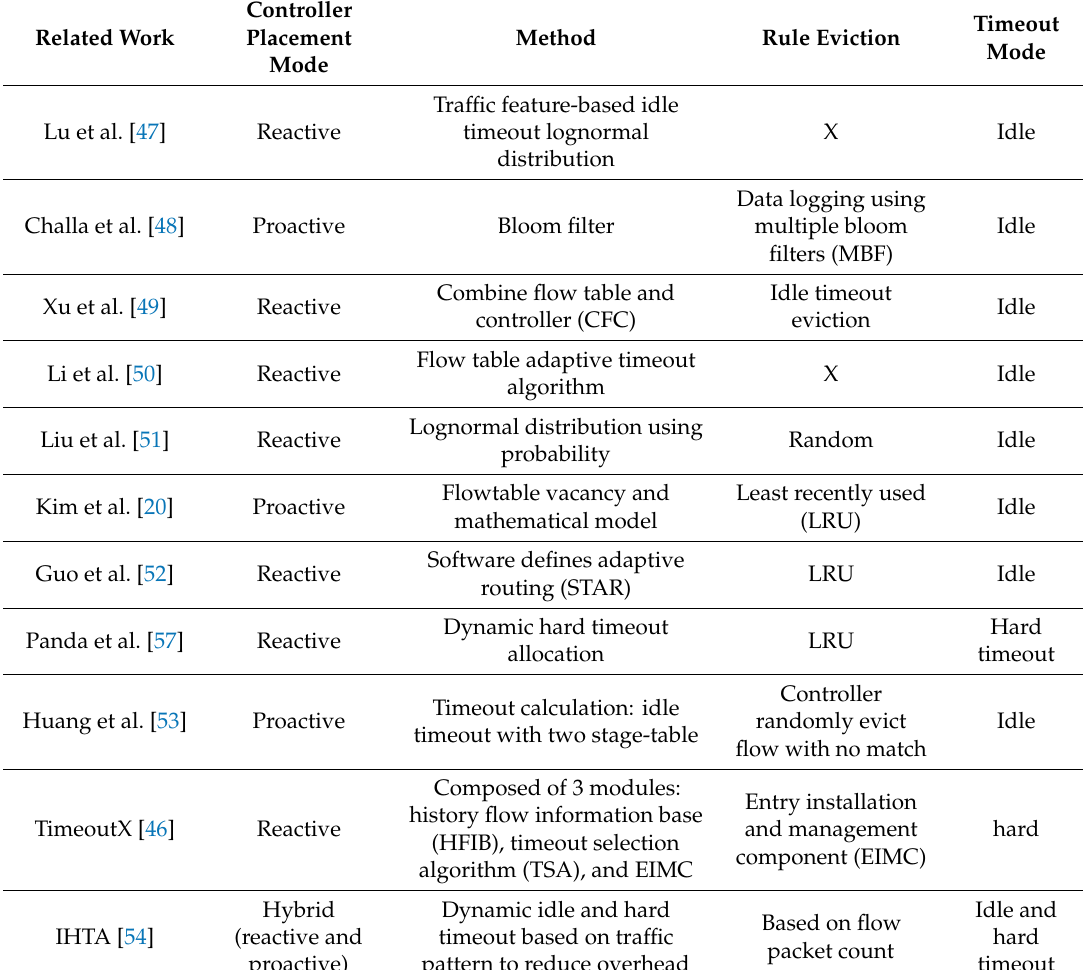
Figure 8. Example of traffic flow with variability of inter arrival time. Table 2. Comparison of proposed flow timeout